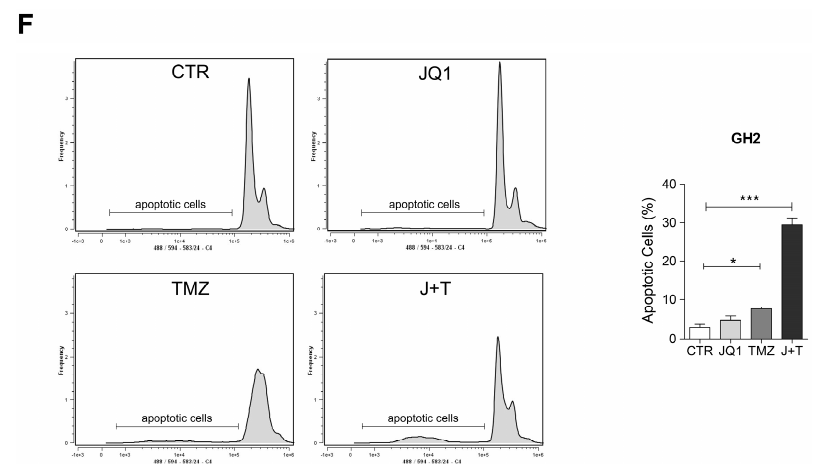
Figure 3. JQ1 sensitizes cells to TMZ. U87 ( A ) and GH2 ( B ) cells were grown in complete DMEM (CTR) or in the presence of 0.5 µ M of JQ1, 500 µ M of TMZ, or both, as indicated. At the indicated time points, the cells were trypsinized and counted in a Newbauer chamber. The graph represents the means ± SEMs of three different experiments. Statistical significance: * indicates significance vs. CTR; # indicates significance vs. TMZ; ◦ indicates significance vs. JQ1; ## p < 0.01, ### p ≤ 0.001, ◦◦◦ p ≤ 0.001 and *** p ≤ 0.001, two-way ANOVA. The U87 ( C ) and GH2 ( D ) cells cultured as in ( A ) and ( B ) were fixed, stained with DAPI, and counted under a fluorescence microscope (using 20X objective). At least 10 fields per each condition were counted. The graphs represent the means ± SDs of three different experiments. * indicates significance vs. CTR; # indicates significance vs. TMZ; and * p < 0.05, ** p < 0.01, and *** p ≤ 0.001, two-way ANOVA. ( E , F ) The U87 ( E ) and GH2 cells ( F ) were cultured as in ( A , B ) for 48 h, and PI-FACS analysis was performed. A PI-positive, subG1 population representing the apoptotic cells is indicated in each panel and in the representative graphs. A total of 10000 cells were counted. The graphs represent the means ± SDs of three different experiments. * indicates significance vs. CTR, and * p < 0.05 and *** p ≤ 0.001, two-way